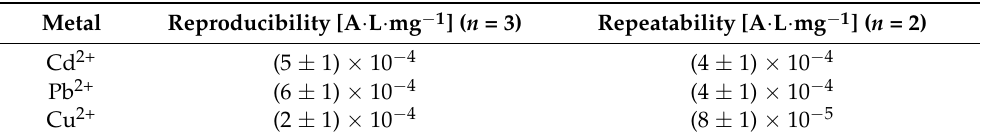
Table 3. Reproducibility and repeatability of multiparametric detection of metal cation detected by the Hg-NPs Route A sensor. The experimental error of these measurements is calculated as the standard deviation for their respective n .